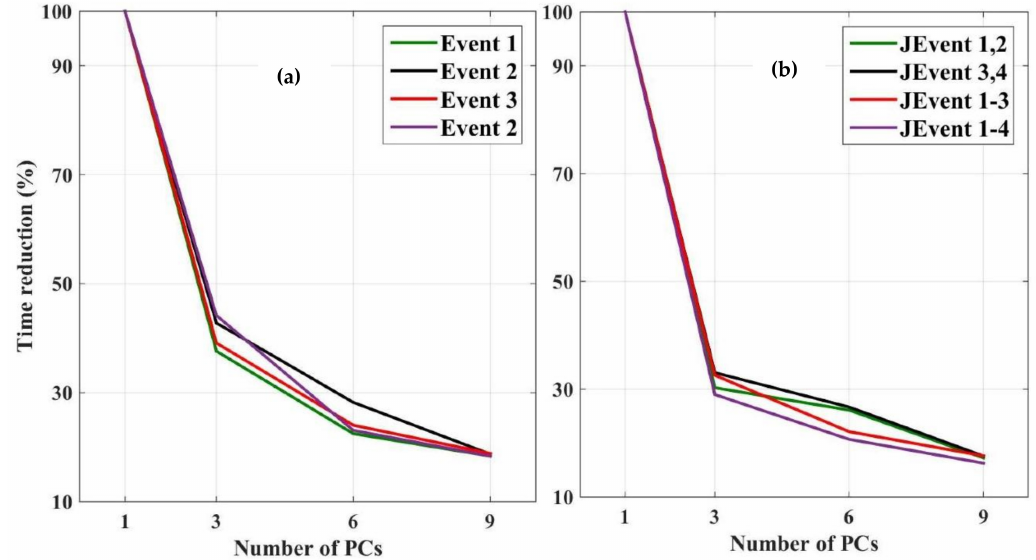
Figure 11. The percent of time reduction for ( a ) single event and ( b ) jointly events of parallelized HMS-PSO.